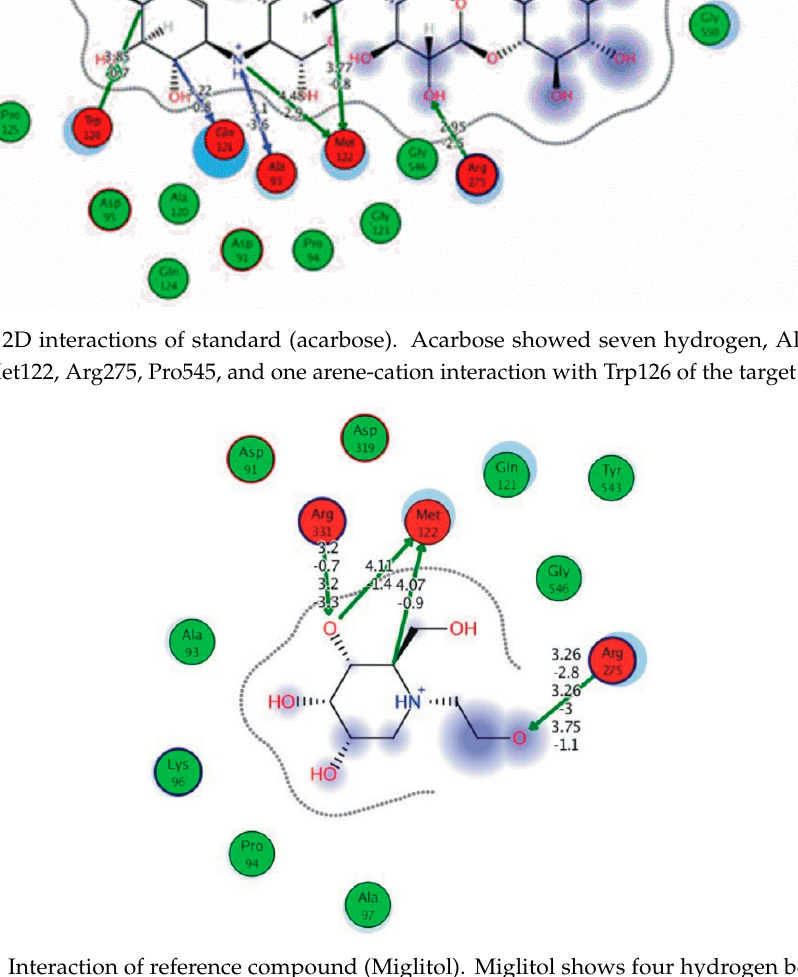
Figure 10. Interaction of reference compound (Miglitol). Miglitol shows four hydrogen bonds with Met122, Arg275, and Arg331 of the target protein active site